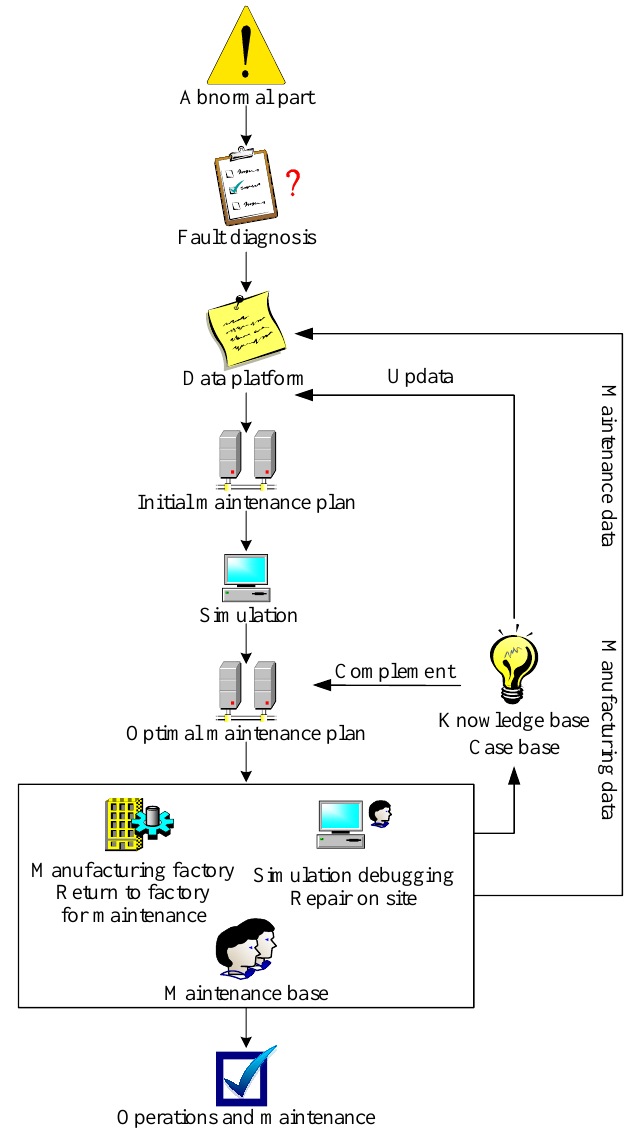
Figure 8. The implementation route of service based on DMS-DT.